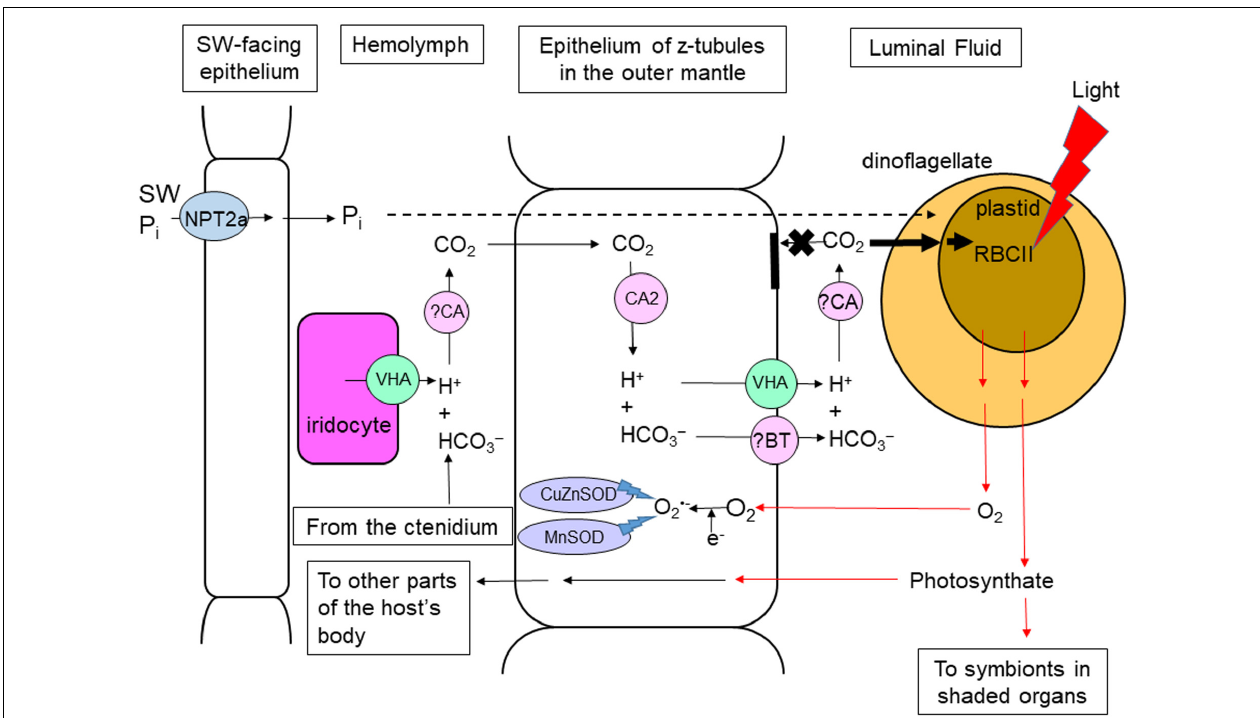
FIGURE 1 | Light-enhanced phenomena and the related mechanisms in the colorful outer mantle of Tridacna squamosa . Substances (e.g., inorganic carbon) supplied by the clam host to the extracellular symbiotic dinoflagellates residing inside the tertiary tubules of the outer mantle must be translocated from the hemolymph through the basolateral and apical membranes of the tubular epithelial cells into the intra-tubular (or luminal) fluid (black arrows). Photosynthate and O 2 produced by the symbionts must go through the reverse route (red arrows) before they can reach the host’s hemolymph. Illumination leads to a significant increase in the protein abundance of form II ribulose bisphosphate carboxylase/oxidase (RBCII) in these symbiotic dinoflagellates (Poo et al., 2020). To supply CO 2 effectively to the photosynthesizing symbionts, the outer mantle of the host possesses a light-enhanced carbon concentration mechanism, which involves iridocytes and tubular epithelial cells, with Vacuolar-type H + -ATPase (VHA; Ip et al., 2018) and Carbonic Anhydrase 2 (CA2; Ip et al., 2017b) as the major catalytic mechanisms. Due to O 2 released by the symbionts, the host needs to augment the detoxification of superoxide radicals (O 2 - ) by increasing the expression levels of copper zinc superoxide dismutase (CuZnSOD; Hiong et al., 2018) and manganese superoxide dismutase (MnSOD; Chew et al., 2020) in the outer mantle in response to illumination. The host also conducts light-enhanced inorganic phosphate (P i ) absorption through Sodium-dependent Phosphate Transport protein 2a (NPT2a; Chan et al., 2020) and supply it to the photosynthesizing symbionts. ?BT: unidentified Bicarbonate Transporter. ?CA, unidentified Carbonic Anhydrase. SW, seawater. Z-tubule, zooxanthellal